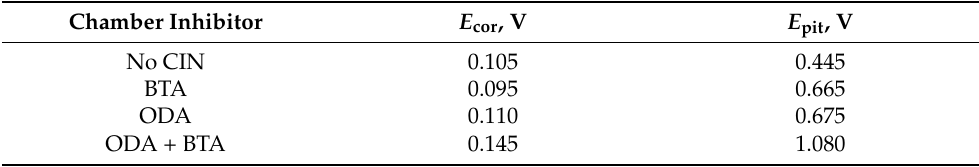
Table 11. Effect of brass CT on the parameters of anodic potentiodynamic curves.